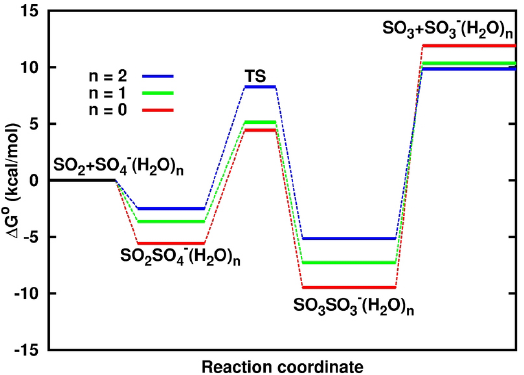
, SO 2 SO − , and 4 4